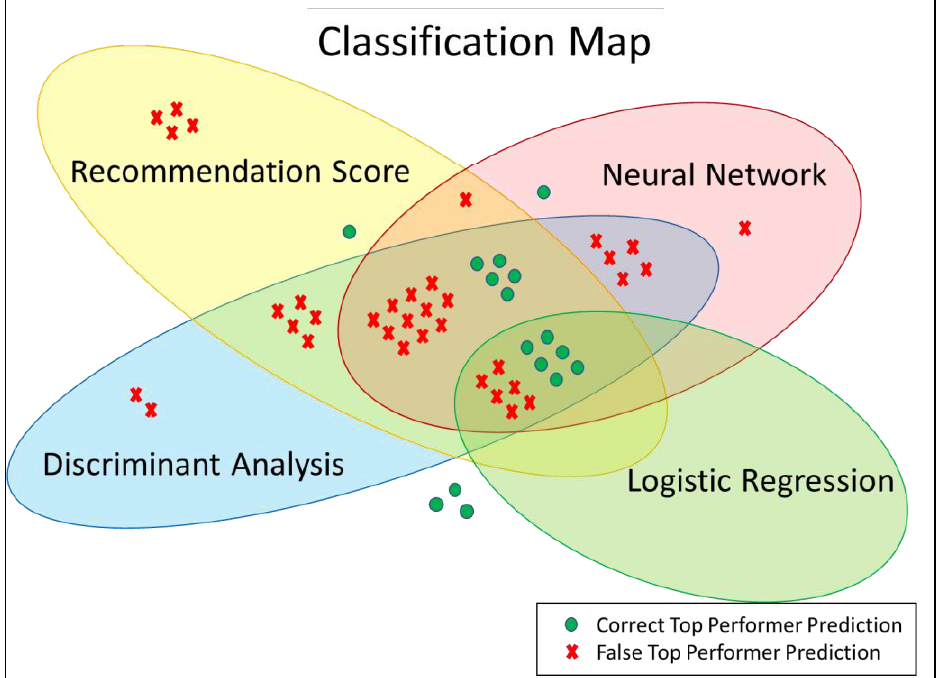
Figure 3. Classification map of correct and false top performer predictions by the four analyses. Six top performers and six low performers were included in the talent prognosis by all four methods. Five other top performers were additionally recognized by all methods except logistic regression. Logistic regression predicted the smallest number of top per- formers overall, and only those who were also recognized by other methods. However, with only twelve predictions, it has the lowest selection rate, but at the same time, with six out of twelve, it has a high rate of hits in terms of its correct identification of top per- formers. A combination of the methods could also provide a high positive predictive value. If only those test participants who were jointly identified in the tennis recommen- dation score, discriminant analysis, and neural network were judged as top performers, 11 future top performers would be correctly classified out of only 28 predictions in total (39.2%). The probabilities at which the analysis methods made correct top-performer recom- mendation are plotted in Table 8. The average values of the cross-validation procedures were converted into a percentage ranking system to facilitate comparison. The cutoff value for a top performer recommendation was uniformly set to 50%. Accordingly, given a percentage value above 50%, an athlete was classified as a top performer. Six top per- formers were recognized by all methods. Their recommendation probabilities ranged from 64% to 99%. Three top performers could not be classified as such. Their recommen- dation probabilities were in the range of 1% to 40%. If we look more closely at the proba- bilities with which the respective analysis methods correctly predicted 1 of the 16 top per- formers, it is noticeable that the logistic regression only provides a very low percentage value for many of the athletes.